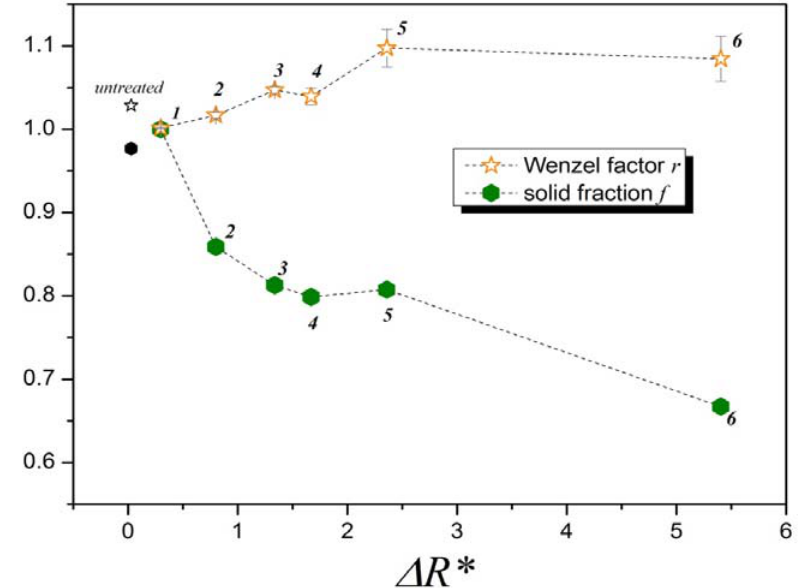
Figure 10. Dependence of Wenzel factor and solid fraction on surface anisotropy (  R* ). The three parameters are dimensionless. Quantities on the Y-axis correspond to r and f . Errors are the standard